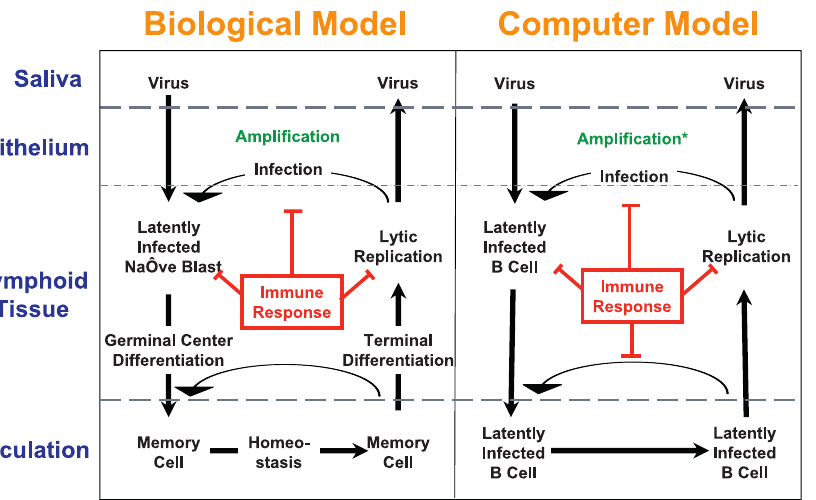
Figure 1. Diagrammatic Representation of the Simulation and the Biological Model on which It Is Based For a detailed description of the biological model, see Introduction and [9–11]. The simulation reflects the biological model with some simplifications (for details see Methods). * denotes that amplification in the simulation is achieved by arbitrarily adding more Vir to the epithelial cell layer at each time step.